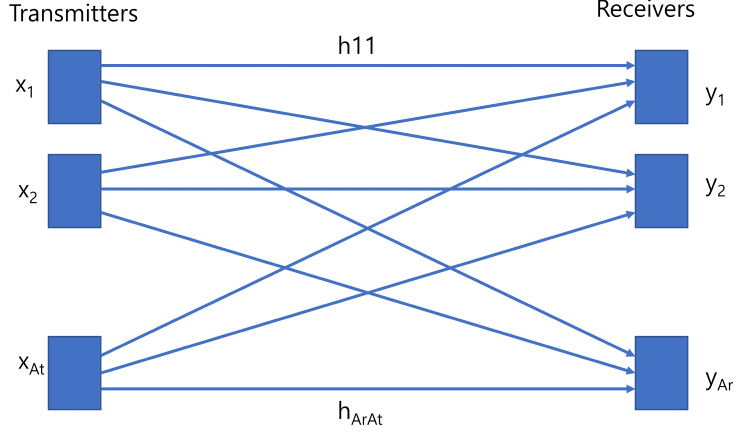
Figure 4. MIMO Communication